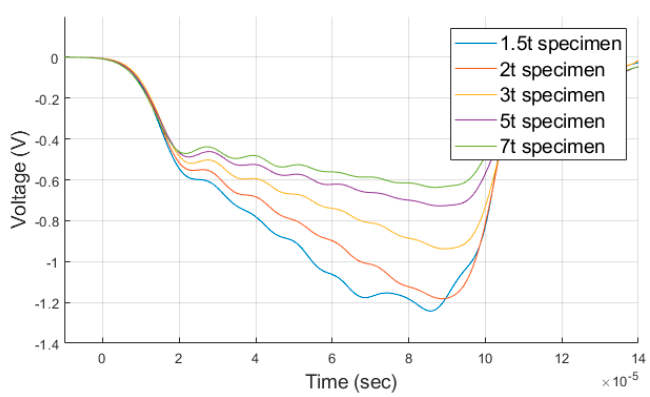
Figure 7. Comparison of the transmitted pulse waveforms, measured in the analysis for each